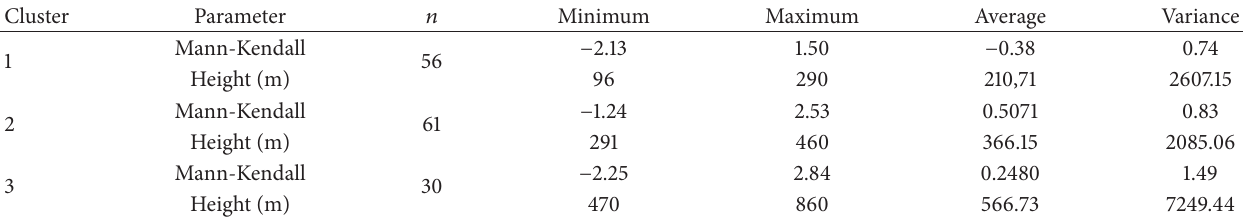
Table 6: Values from 𝑘 -means cluster analysis for values of Mann-Kendall test, for annual series of number of hailpads impacted from 1990– 2010, and altitude (m) of these pads.